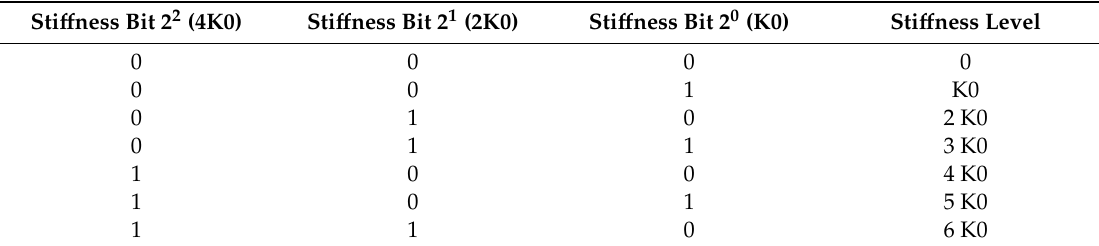
Figure 2. ( a ) The CAD representation of discrete variable stiffness actuator. ( b ) The schematic representation of the working principle of the actuator. Table 1. The total possible stiffness levels of the DVSA.